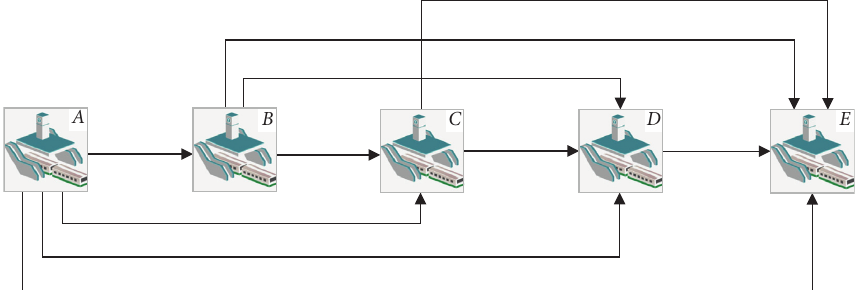
Figure 6: Single train running in four OD